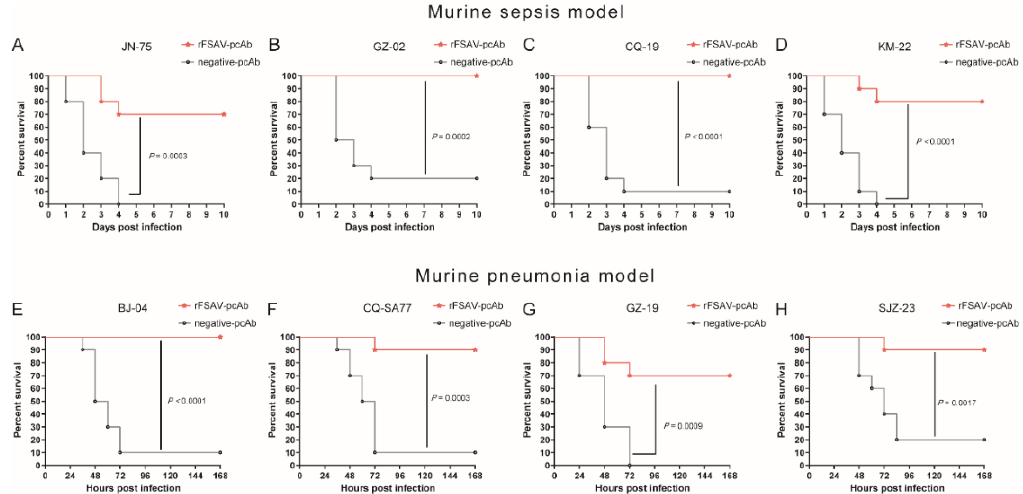
Figure 6. rFSAV-pcAb broadly protected mice from di ff erent clinical S. aureus strains challenge in murine sepsis and pneumonia models. ( A – D ) Protection of passive immunization with rFSAV-pcAbs in the mouse sepsis model. BALB / c mice ( n = 10) were injected intravenously with 100 µ L of rFSAV-pcAbs or negative-pcAbs (20 mg / mL). Two hours later, the mice were challenged with JN-75, CQ-19, GZ-02 or KM-22 (3.0 × 10 8 , 5.0 × 10 8 , 7.0 × 10 8 or 2.0 × 10 8 CFUs / mouse, respectively) by tail intravenous injection. The survival rate was monitored for 10 days. ( E – H ) Protection of passive immunization with rFSAV-pcAbs in the mouse pneumonia model. C57BL / 6 mice ( n = 10) were injected intravenously with 100 µ L of rFSAV-pcAbs or negative-pcAbs (20 mg / mL). Two hours later, the mice were challenged with BJ-04, CQ-SA77, GZ-19 or SJZ-23 (9.0 × 10 8 , 4.0 × 10 8 , 3.0 × 10 8 or 4.0 × 10 8 CFUs / mouse, respectively) by intratracheal injection. The survival rates were recorded every 12 h over a 7-day observation period post challenge. ( A – H ) The Mantel-Cox log-rank test was used to compare di ff erences between passive immunization and control